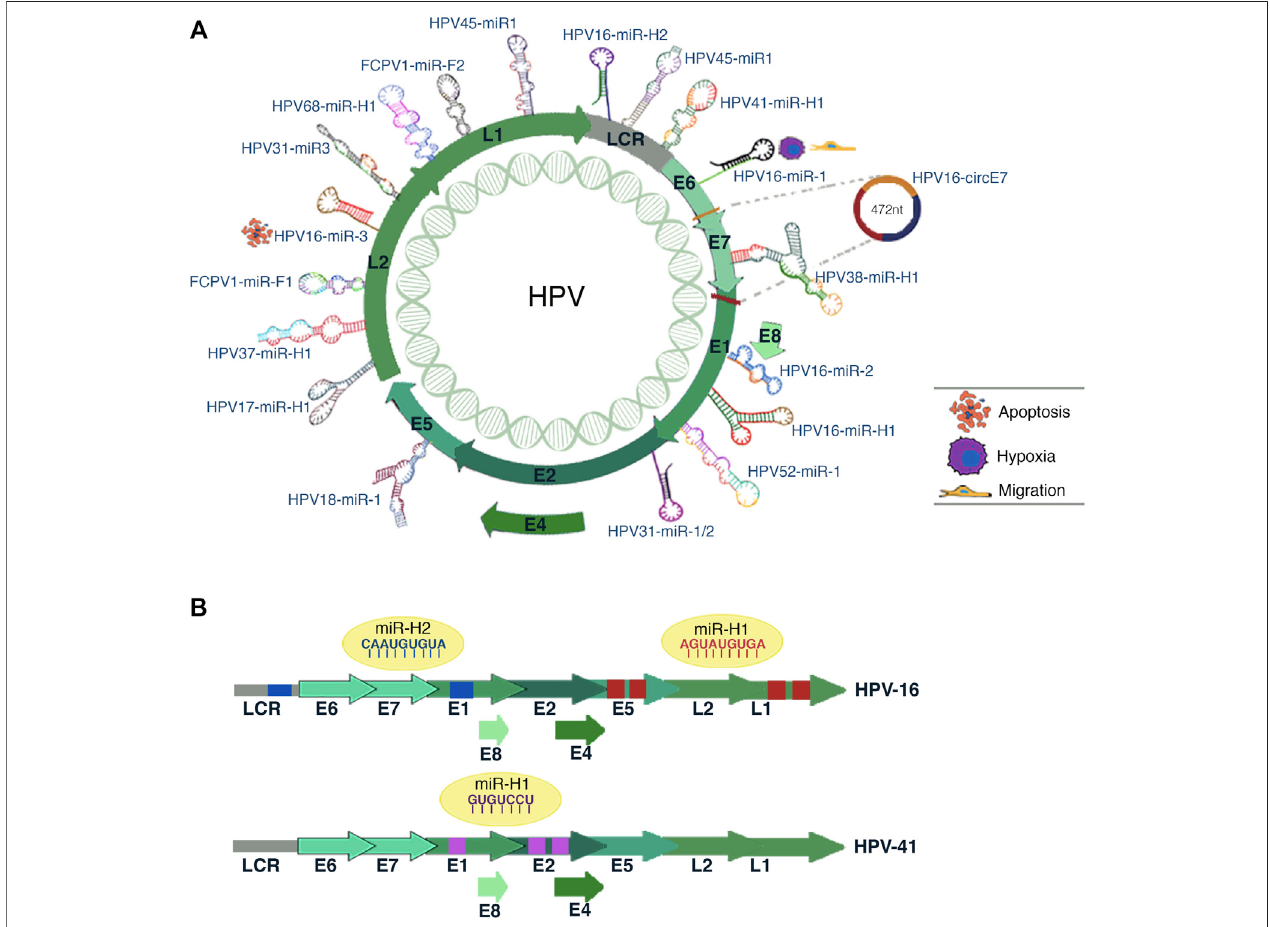
FIGURE4| HPV-encodedmiRNAs. (A) IllustrationshowsthemiRNAscodingsiteinsidethegenomeofdifferentHPVsubtypes.Thepredictedbiologicalprocesses for some HPV16 miRNAs are depicted in the fi gure. The circE7 synthesis site is also shown. (B) The scheme represents the potential interaction sites of miRNAs in the viralgenomeofHPV-16andHPV-41.ThepredictedtargetviralsequenceslocationforeachmiRNAareshowninthesamecolorasthecorrespondingmiRNAsequence (blue, red, or purple).